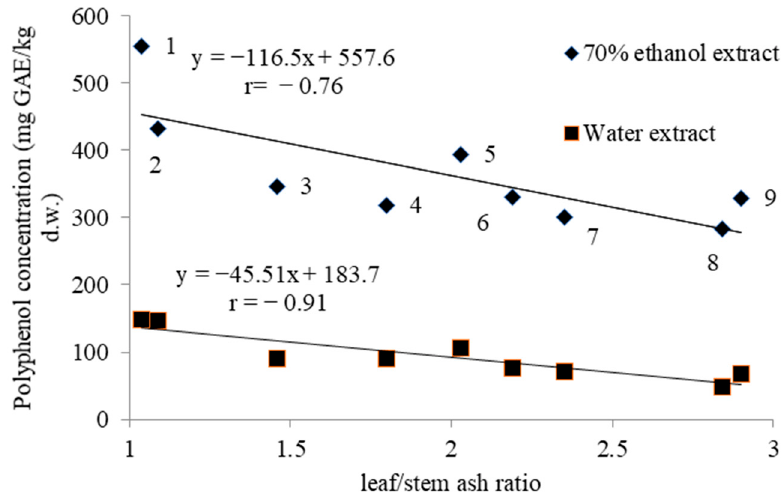
Figure 5. Correlations between leaf/stem ash content and stem polyphenol concentration: 1) Goliath; 2) Premier; 3) Camus; 4) Kalambus; 5) Bandit; 6) Giraffe; 7) Vesta; 8) Cazimir; 9) Summer Breeze.